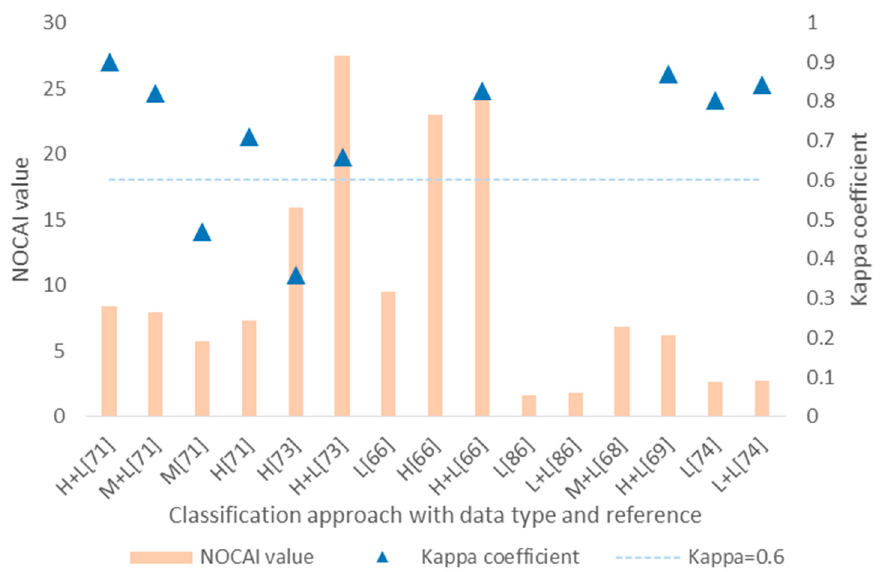
Figure 3. Comparison of classification accuracy using the kappa coefficient and number of categories adjusted index (NOCAI) value, where the form of “A+B” represents the combination of different datasets; H, M and L represent hyperspectral, multispectral and LiDAR data, respectively; the studies of methods of data combination and classification results are cited in the square brackets.